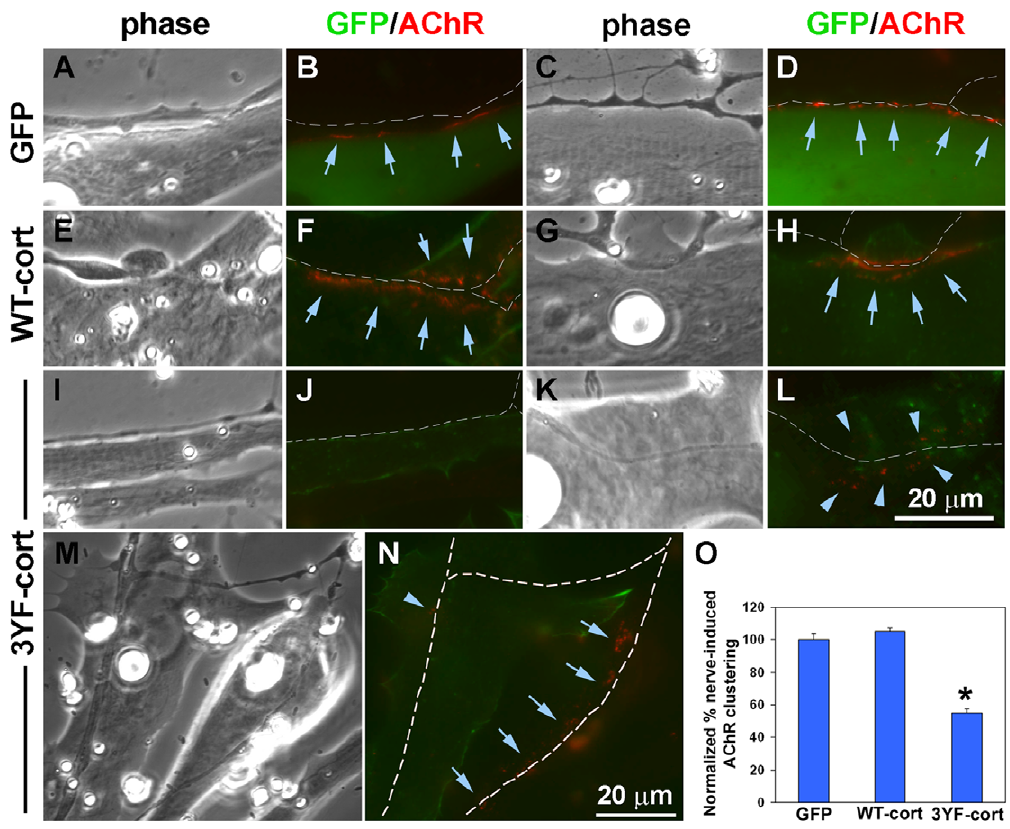
Figure 7. Suppression of synaptic AChR aggregation by phospho-mutant cortactin expressed selectively in muscle cells. Xenopus embryonic muscle cells expressing GFP (A-D) and GFP-tagged wild-type cortactin (WT-cort; E-H) and phospho-mutant cortactin (3YF-cort; I-N) were co-cultured with spinals neurons for 1 d and then labeled with R-BTX to visualize AChR clusters. Cells expressing the exogenous proteins fluoresced green and AChR clusters appeared red, as shown in this figure with 2-3 representative examples of nerves contacting muscle cells with GFP or GFP- tagged cortactin proteins. In the GFP and WT-cort muscle cells (A-H), AChRs were tightly clustered (arrows) along nerve-contacts identified (traced in white in colored panels) but this was not the case in 3YF-cort cells where nerves often induced no AChR clustering (J) or induced few clusters that were loosely organized (L; arrowheads). We found cases where the same neurites moved across normal muscle cells and 3YF-cells (M-N) and in such cases synaptic AChR clustering was robust in the normal cells (arrows) but not mutant cells (arrowheads). O. The percentages of nerve-contacts with AChR clusters were determined by examining several co-cultures with muscle cells expressing GFP or the GFP-tagged cortactin proteins (see Methods) and these values were normalized relative to numbers obtained from examining nerve-contacts on GFP-cells. In muscle cells expressing phospho-mutant cortactin, synaptic AChR clustering was almost halved. Nerve-muscle contacts examined: GFP cells, 168; WT-cort cells, 214; 3YF-cort cells, 225; mean and SEM shown, *P ,